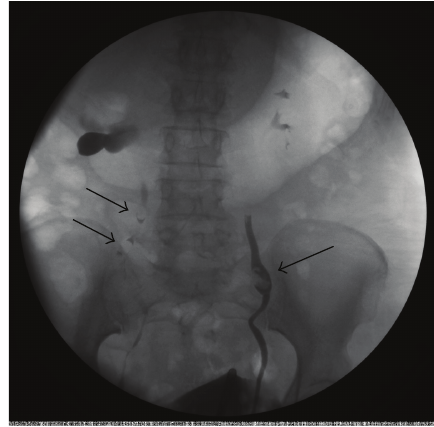
Figure 2: Retrograde pyelograms demonstrating bilateral filling defects in both ureters (black